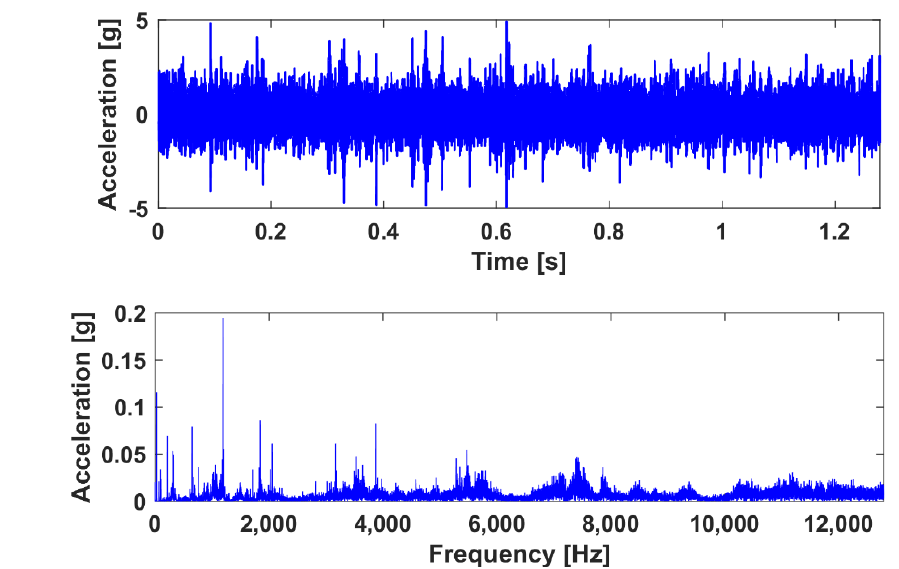
Figure 5. ( a ) The horizontal acceleration signal and ( b ) its amplitude spectrum in Case A .